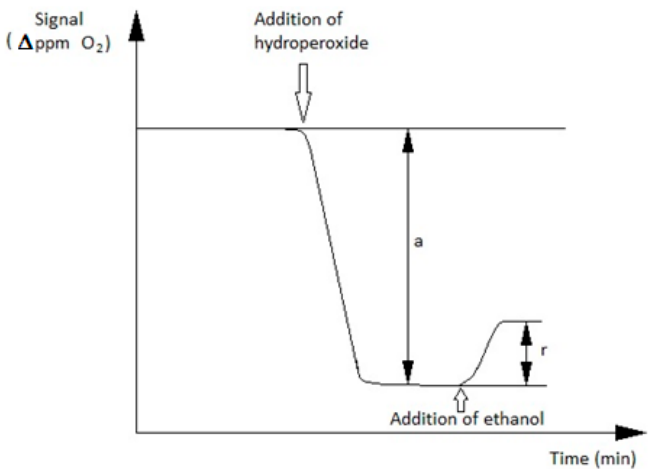
Figure 2. Trend of catalase biosensor response during a typical measurement of ethanol concentration, operating in decane.